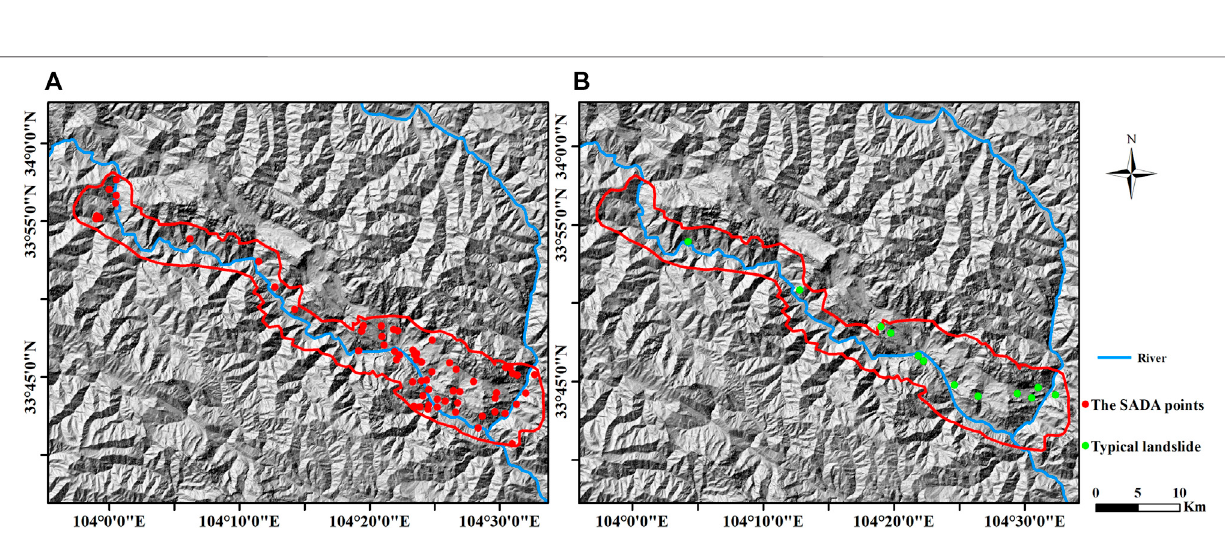
FIGURE 8 | SADA and landslide maps. (A) Final result of the SADA distribute and (B) typical landslide